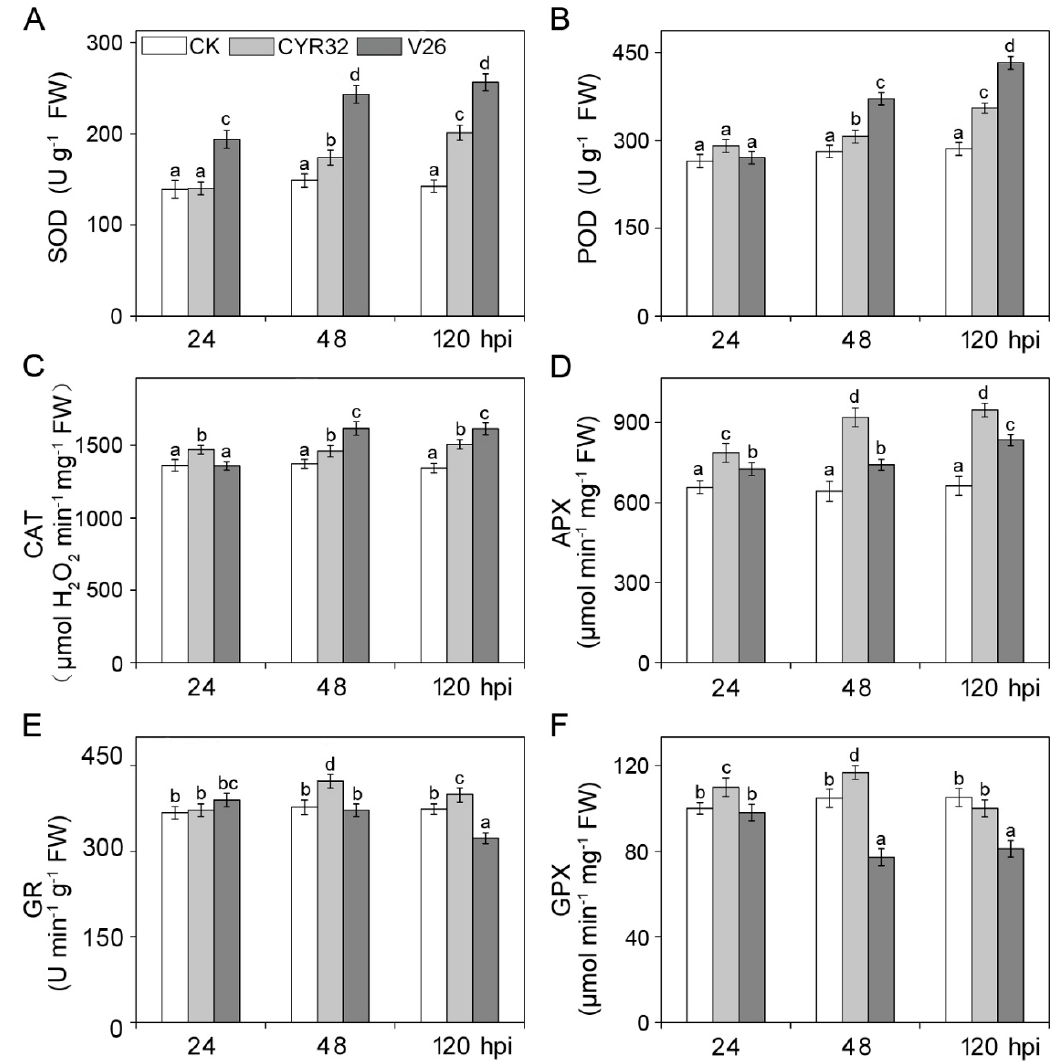
Figure 4. The activities of six antioxidant enzymes in wheat cultivar CM42 inoculated with CYR32 and V26. SOD, superoxide dismutase ( A ). POD, peroxidase ( B ). CAT, catalase ( C ). APX, ascorbate peroxidase ( D ). GR, glutathione reductase ( E ). GPX, glutathione peroxidase ( F ). Bars represent standard deviations (SD), which were calculated from four independent biological replicates ( n = 4). Different letters note significant differences among different treatments ( p < 0.05) following Duncan’s multiplication range test. CK, un-inoculated wheat plants. 24–120 hpi represent 24, 48, and 120 h after inoculation.